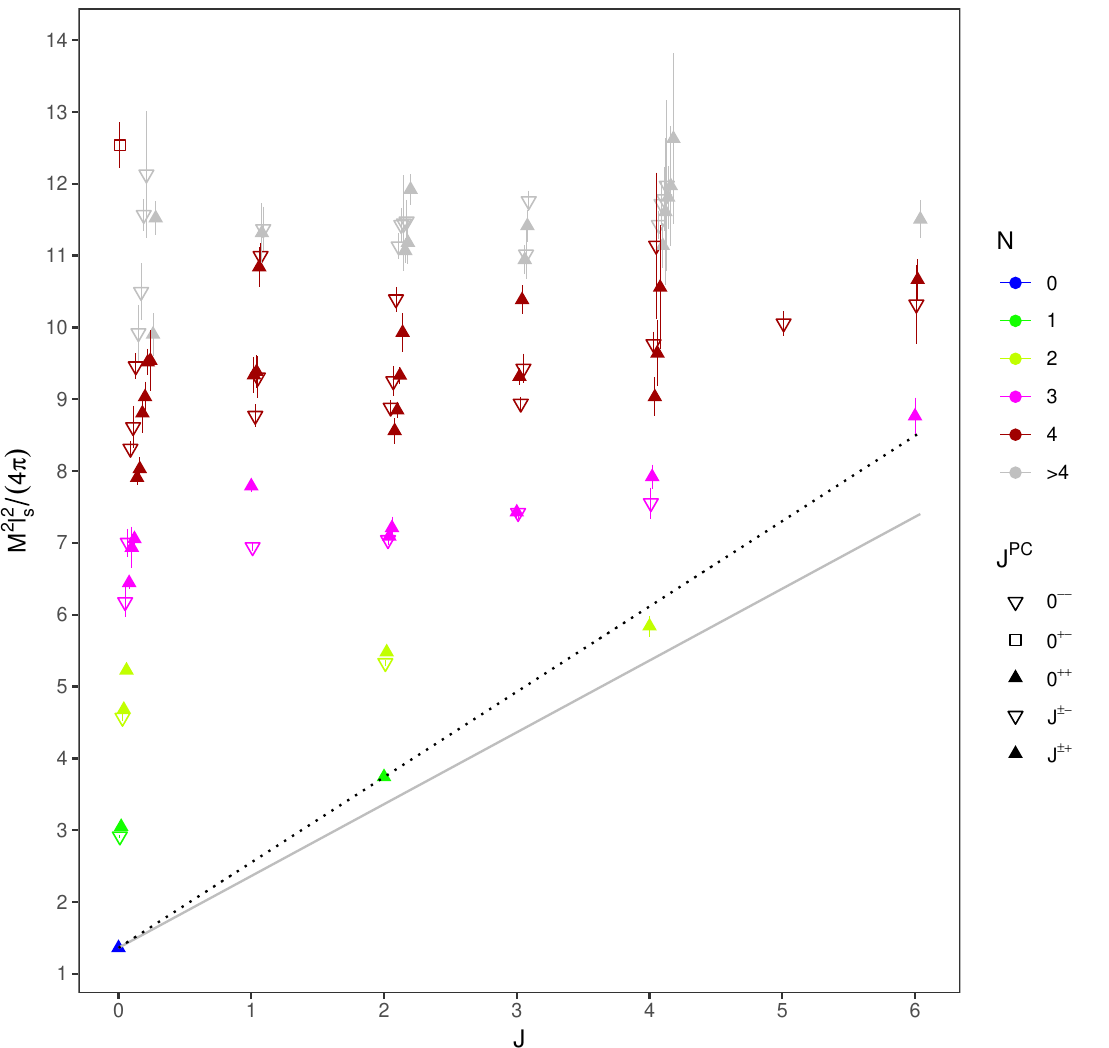
Figure 9. The Chew-Frautschi plot with color coded level assignment; masses are obtained us- ing conventional operators and the J assignments are based on overlaps with AR eigenstates. The dotted line is the weighted least squares (cid:12)t to the leading Regge trajectory ( M 2 l 2 4 (cid:25) (1 : 362(6) + 1 : 19(1) J )). The light solid line is the linear Regge trajectory with a unit slope line starting at 0 ++ ground